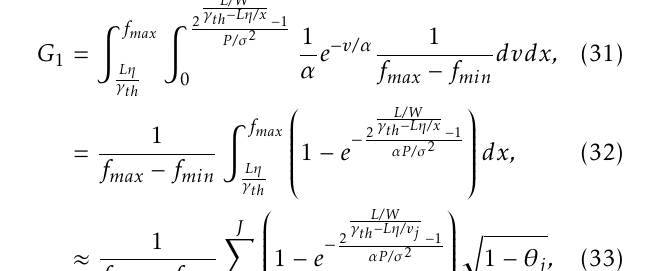
Figure 2. Outage probability versus the task length L for criterion I.